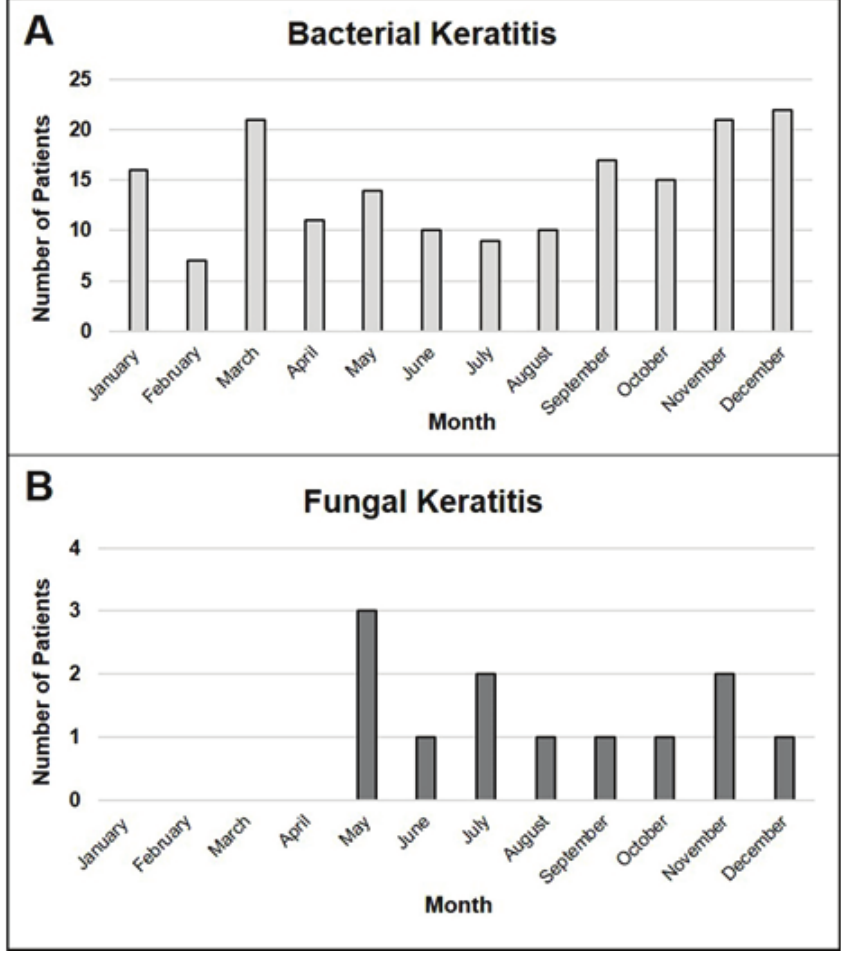
Figure 1. Seasonal distribution of occurrence of bacterial (A) and fungal (B) keratitis in South